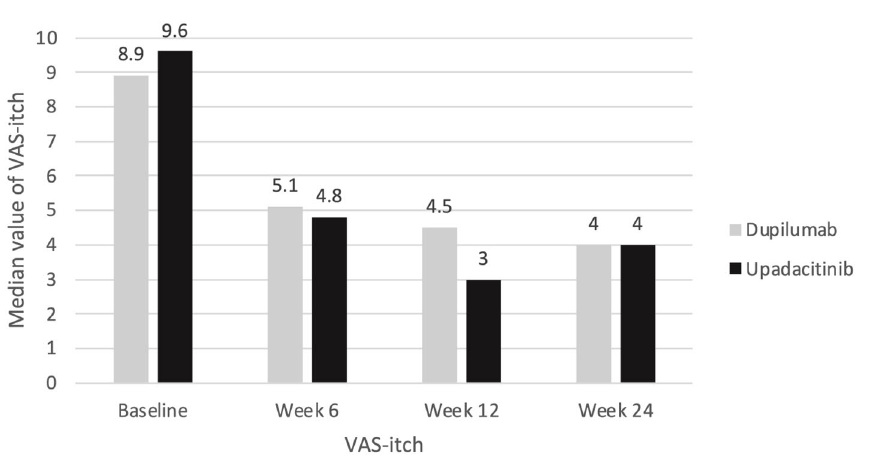
Figure 5. Median VAS-itch score; p -value in Mann–Whitney U test for dupilumab ( n = 16) vs. upadacitinib ( n = 7) subgroup comparison (all time p > 0.05).